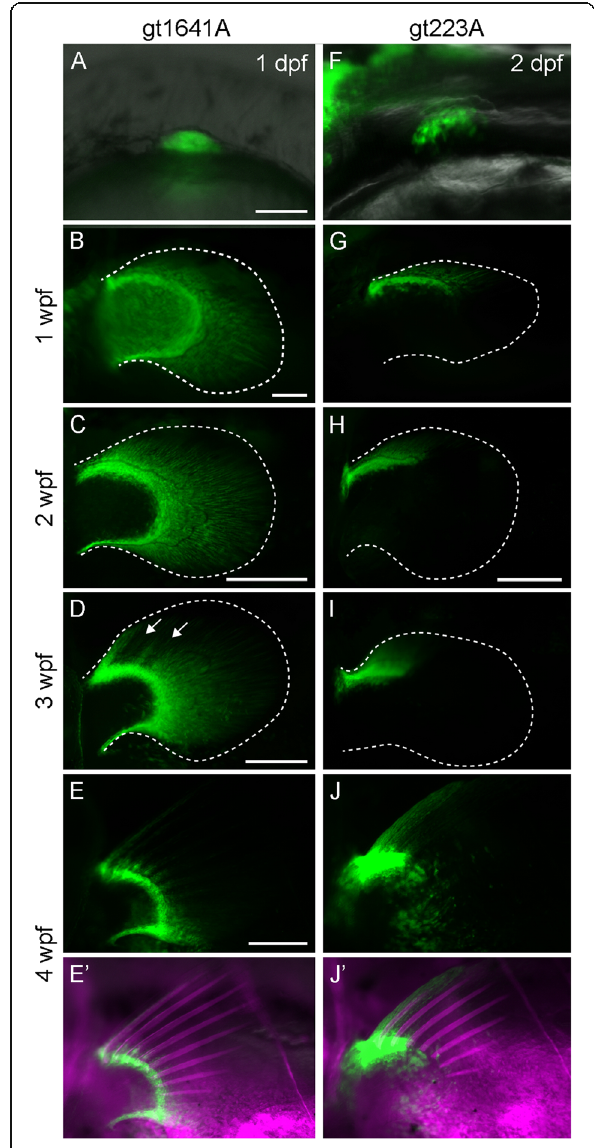
Fig. 5 Expression pattern of EGFP in the pectoral fin of gt1641A and gt223A transgenic zebrafish. a - e ’ . Expression pattern of EGFP in the pectoral fin of a gt1641A transgenic fish observed at 1 dpf ( a ), 1 wpf ( b ), 2 wpf ( c ), 3 wpf ( d ), and 4 wpf ( e , e ’ ). f - j ’ . Expression pattern of EGFP in the pectoral fin of a gt223A transgenic fish observed at 2 dpf ( f ), 1 wpf ( g ), 2 wpf ( h ), 3 wpf ( i ), and 4 wpf ( j , j ’ ). White dashed lines indicate outline of the fin fold in the pectoral fin. Arrows in d indicate depletion of EGFP expression. Magenta in e ’ and j ’ indicate calcified bones stained by Alizarin Red. Scale bars in a and b and those in c , d , e , and h indicate 75 μ m and 250 μ m,